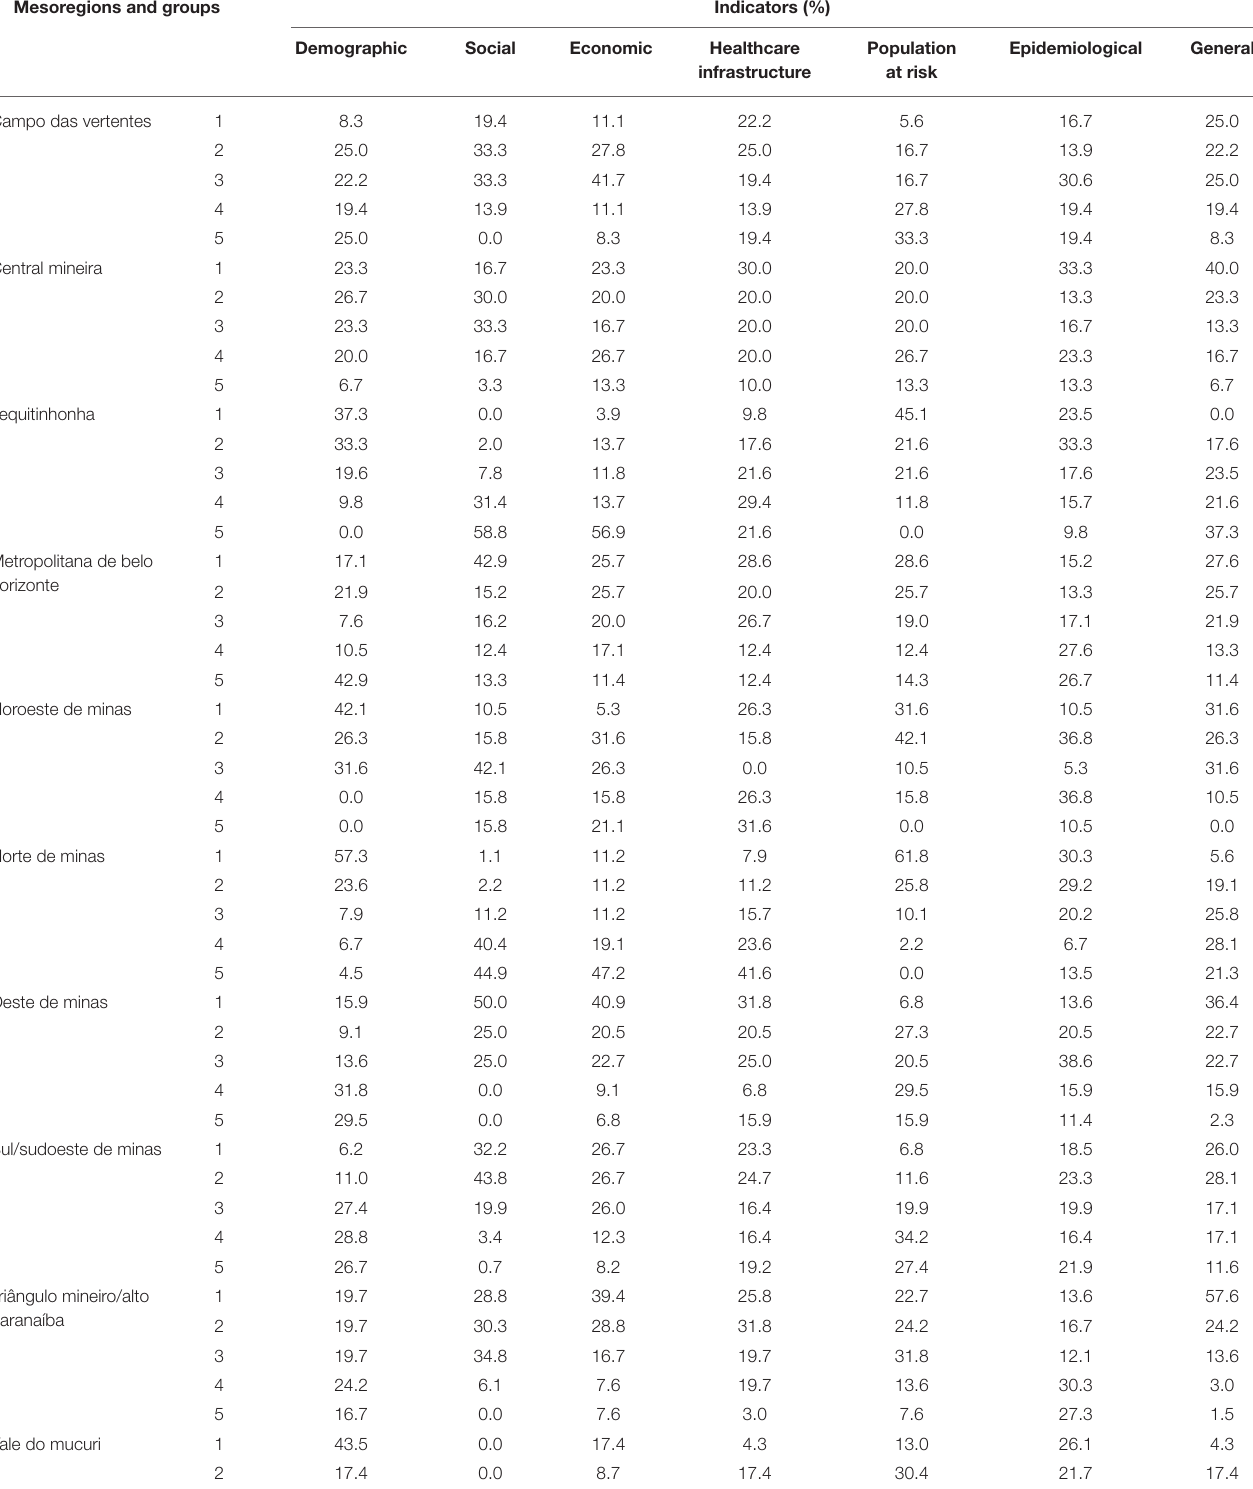
TABLE 3 | Mesoregions of municipalities and groups of vulnerability (1 and 2 representing lower vulnerability, 3 moderate vulnerability and 4 and 5 greater vulnerability) for COVID-19 in the state of Minas Gerais, according to indicators used in the multi-criteria decision analysis. Mesoregions and